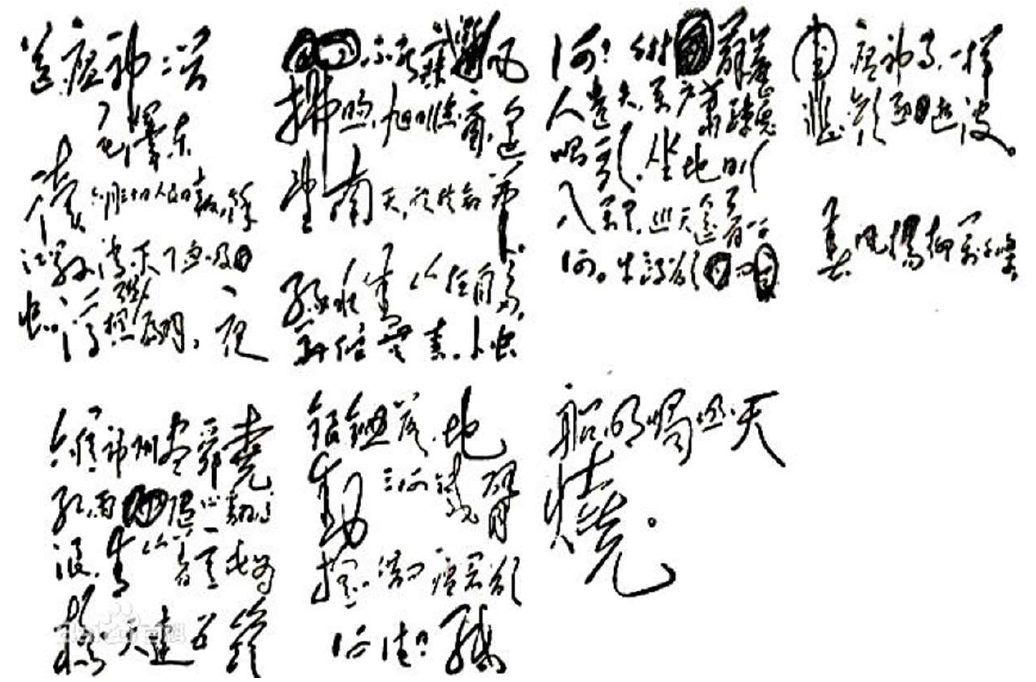
Figure 1. Chairman Mao Zedong’s “Farewell to the God of Plague" in his own handwriting.